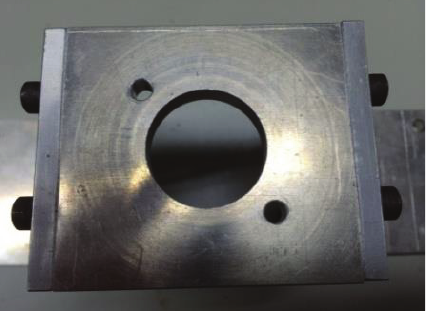
Figure 7: Iron base with